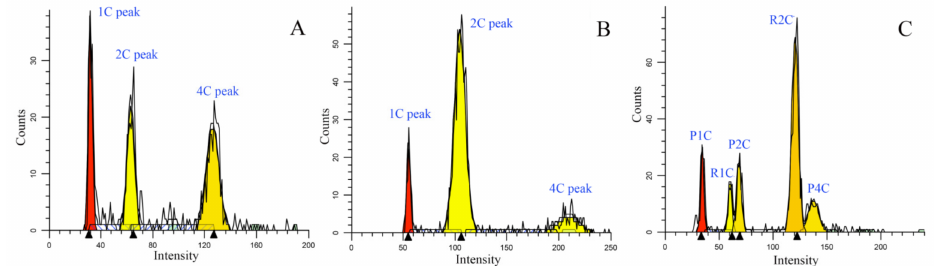
Figure 8. Histograms of counts versus fluorescence using flow cytometry for Physcomitrella patens ( A ), Rhodobryum giganteum ( B ), and for R. giganteum with P. patens as the internal standard ( C ). Note: In Figure C, P1C, P2C and P4C are peaks for P. patens , R1C and R2C for R. giganteum,